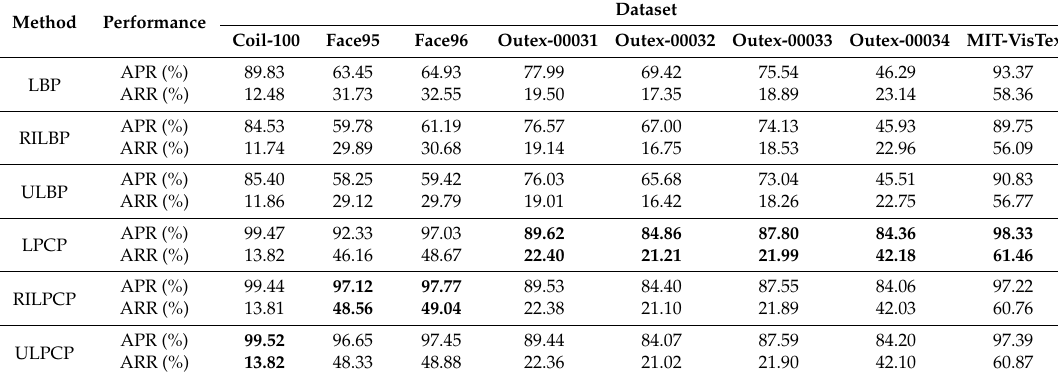
Table 3. The performance comparisons among the proposed descriptors and the local binary pattern (LBP)-based descriptors on the eight